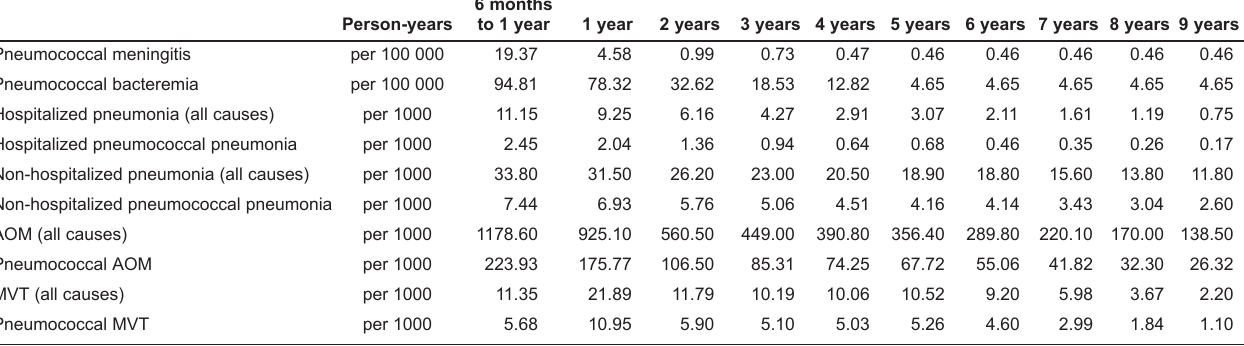
TABLE 1 Age-specific incidence rate of pneumococcal-related outcomes in a cohort of Canadian